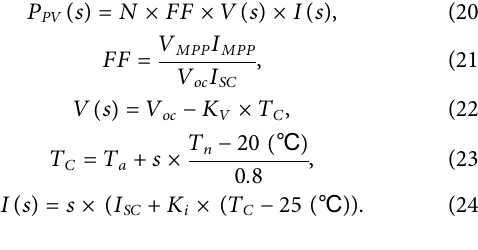
Frontiers in Energy Research |